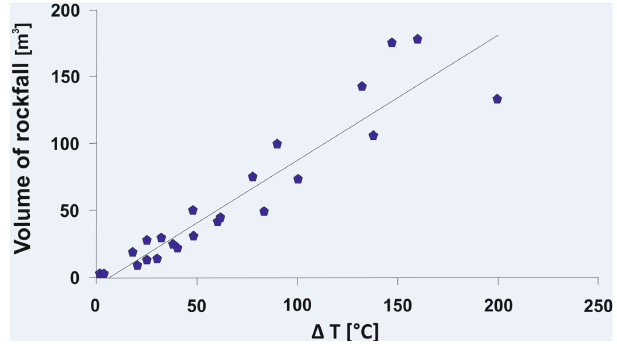
Fig. 6. Relationship of rockfall volume estimated from photos taken before and after and the temperature difference measured at the ex- posed dome face; R 2 is